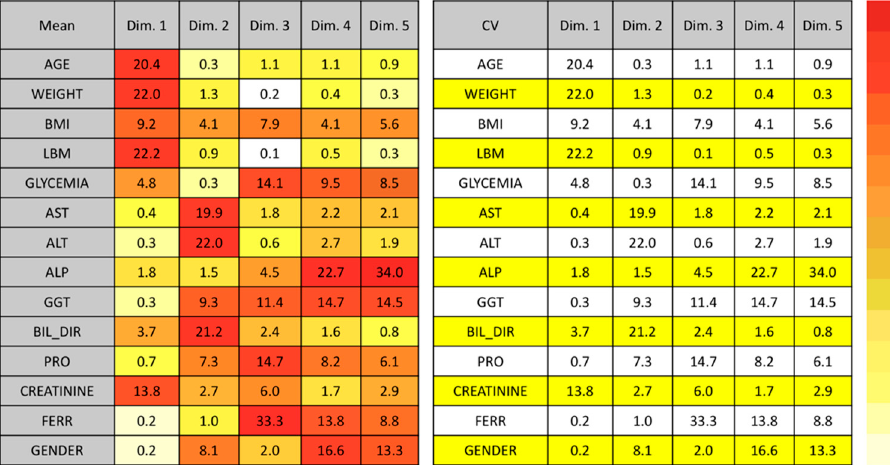
Figure 1. Factor analysis of mixed data (FAMD) results. The darkest red cells on the left correspond to the highest weight of the covariates. Numbers within cells, mean ( left ) and CV ( right ) values.